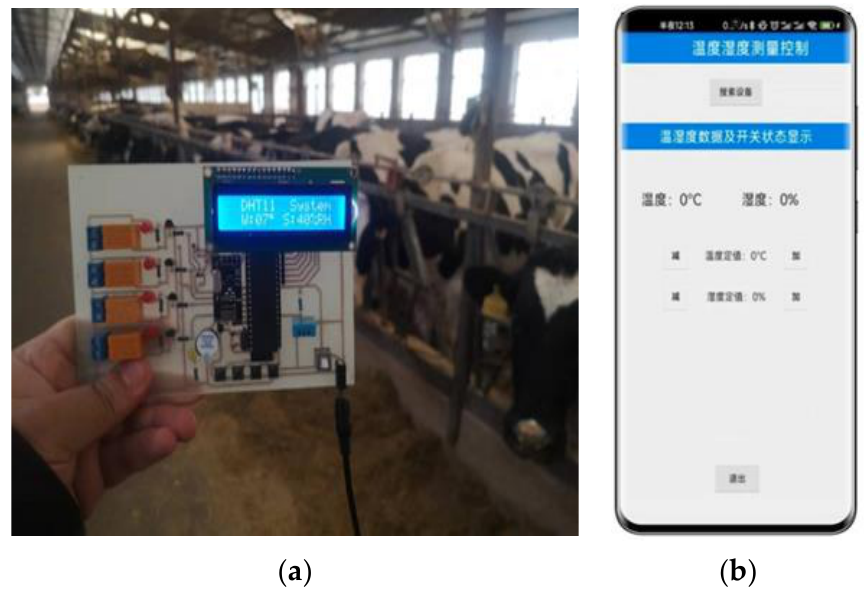
Figure 3. ( a ) Physical diagram of mobile temperature and humidity wireless collection device; ( b ) temperature and humidity measurement and control APP interface. “ 温度湿度测量控制 ” means Temperature and humidity measurement control; “ 搜索设备 ” means Search equipment; “ 温湿度数据及开光状态显示 ” means Temperature and humidity data and light status display; “ 温度 ” means Temperature; “ 湿度 ” means Humidity; “ 温度定值 ” means Temperature setting; “ 湿度定值 ” means Humidity setting; “ 加 ” means Addition; “ 减 ” means Subtraction; “ 退出 ” means Withdraw.